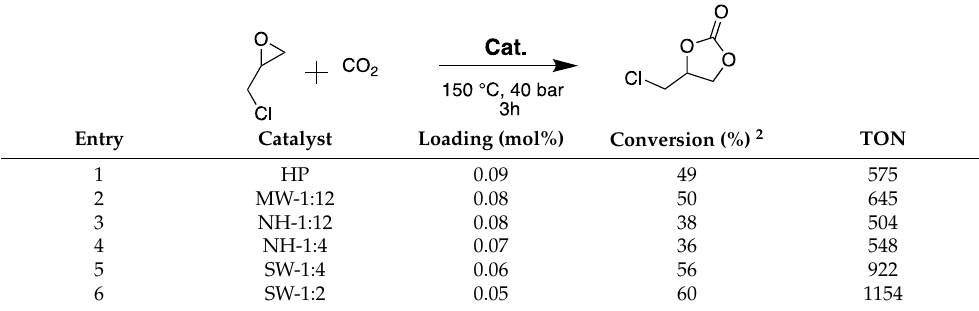
Table 2. Catalytic activity of the hybrid materials in the reaction between epichlorohydrin and CO 2 . 1